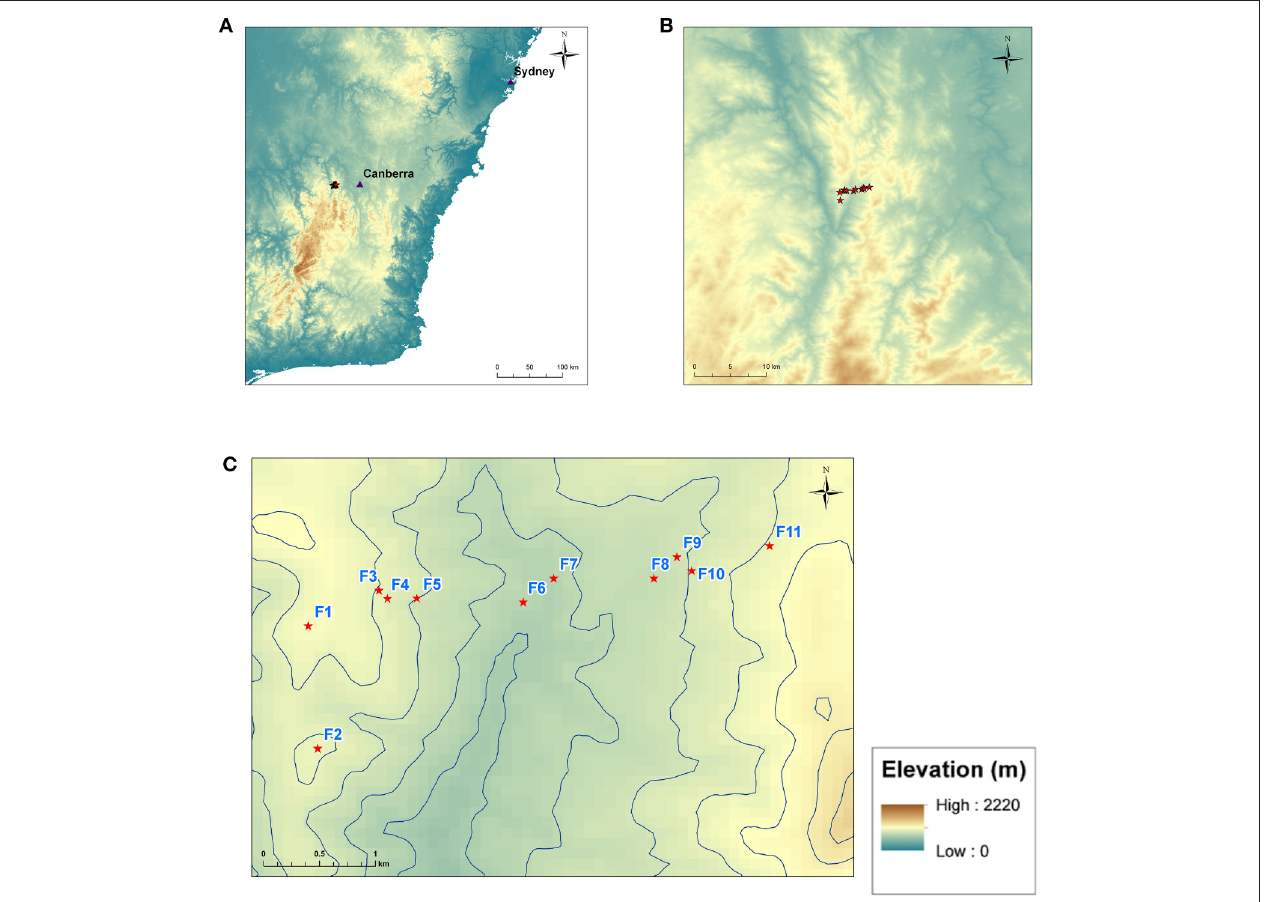
FIGURE 1 | Maps showing the locations of weather station sites. (A) Shows south-eastern Australia, (B) shows the broad topography surrounding the study region, and (C) shows the location of the eleven weather stations F1–F11 across Flea Creek Valley.